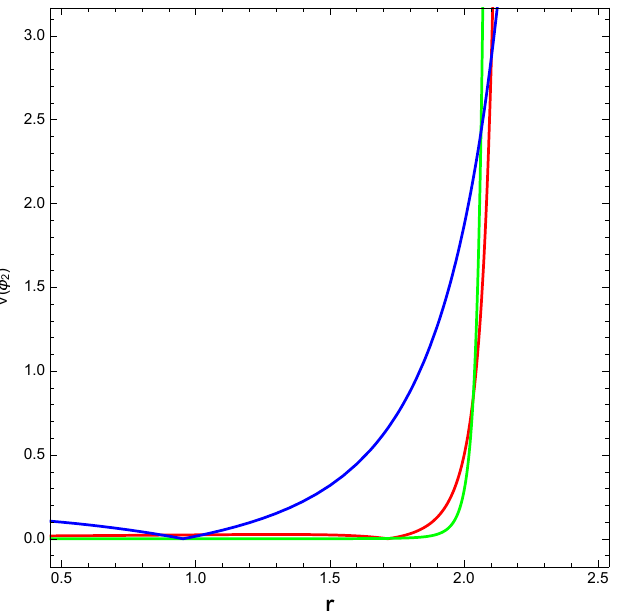
Figure 10. Solution of the scalar potential for R adopted as a quadratic function of radius. The evolu- tion of the scalar potential V ( φ 2 ) is presented by Equations (8) and (32). We have fixed the values of a 0 , a 1 , a 2 , K , and C 1 . The red, green, and blue lines correspond to small perturbations of λ 0 , Ψ 0 , η 1 , η 2 , and η 3 ,